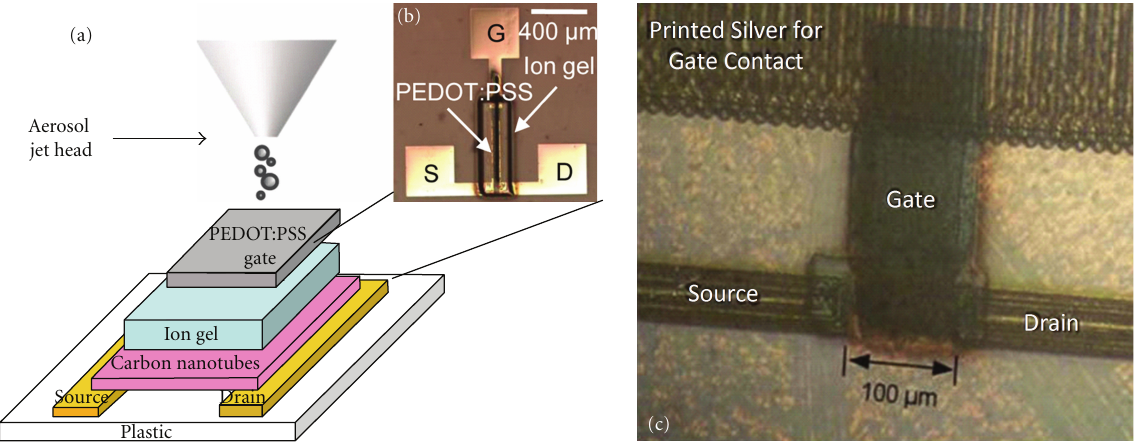
Figure 20: (a) Schematic representation of an Aerosol Jet printed CNT-based TFT. Source and drain were lithographically patterned while active (CNT), dielectric (ion gel), and gate (PEDOT:PSS) were made with Aerosol Jet. (b) Image of patterned TFT [96]. Copyright 2010 American Chemical Society. (c) Image of CNT based TFT with silver contacts produced by Aerosol Jet, spin-coated CNT film, ion gel dielectric, and PEDOT:PSS gate, reprinted from King and Renn, and Jones et al. [87, 97]. Copyright 2010, with permission from Optomec and Elsevier,